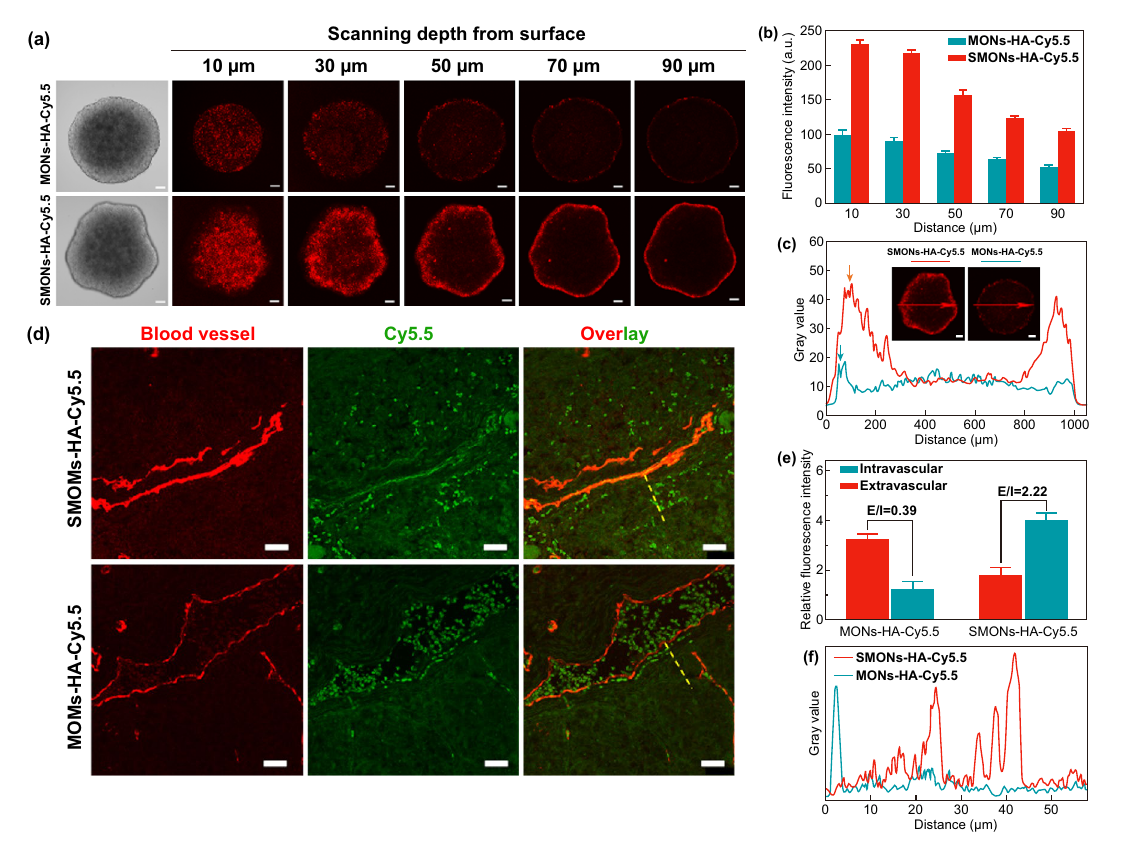
Fig. 5 Penetrating behavior. a CLSM Z-stack scanning images and b corresponding fluorescence intensity of MCF-7 multicellular spheroids (MCSs) upon 4 h incubation with the MONs-HA-Cy5.5 and SMONs-HA-Cy5.5. Scale bars, 100 µm. c Gray value profile of MCSs along the arrow region at the Z-axis distance of 50 µm. d CLSM images of tumor slices from mice at post-24 h injection. Red and green signals were from anti-CD31 stained blood vessels and Cy5.5, respectively. Scale bars, 25 µm. e Relative Cy5.5 fluorescence intensities of intravascular and extravascular areas. f The grey value profile of green signal of extravascular areas (indicated by the yellow dashed lines). (Color figure